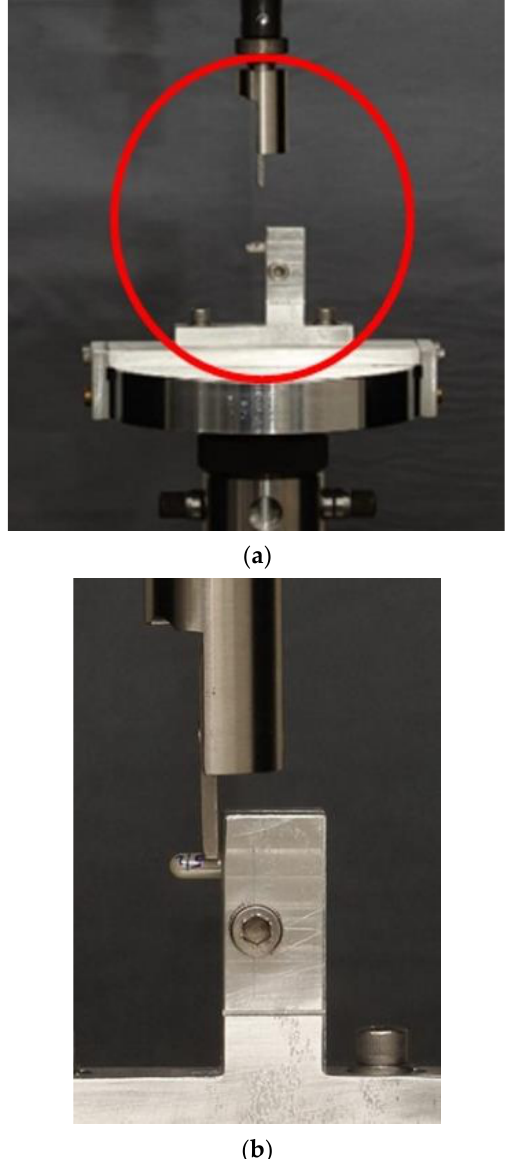
Figure 1. Sample mounted in the universal testing machine ( a ), shear force application at the ingot-cement interface ( b ).